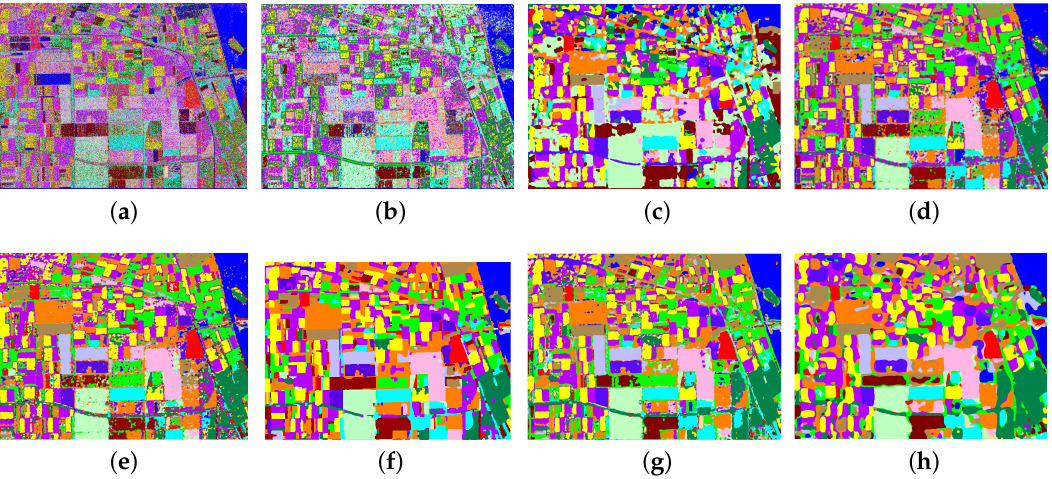
Fig. 5. Classification results of Flevland area data with different methods. (a) SVM classifier [5]. (b) WBRBM classifier [9]. (c) WDBN classifier [9]. (d) WDSN classifier [10]. (e) CNN classifier [11]. (f) MLR sub MLL classifier [58]. (g) Wishart classifier [1]. (h) SSA classifier [27]. (i) SNC classifier [29]. Figure 9. Classification results on dataset Flevoland with different methods, including ( a ) (j) KWGraphCNN classifier. (k) SPGraphCNN classifier. variational mixture Wishart (VMW) [26], ( b ) support vector machines (SVM) [29], ( c ) robust semi-supervised [21], ( d ) real-valued CNN (RV-CNN) [32], ( e ) complex-valued CNN (CV-CNN) [51], over-smoothed and misclassified after iterations of optimiza- tion. For example, the road area [marked by red rectangles ( f ) graph semi-supervised (GSS) [44], and ( g ) our former CLSL [50] model and ( h ) proposed SLMC methods,